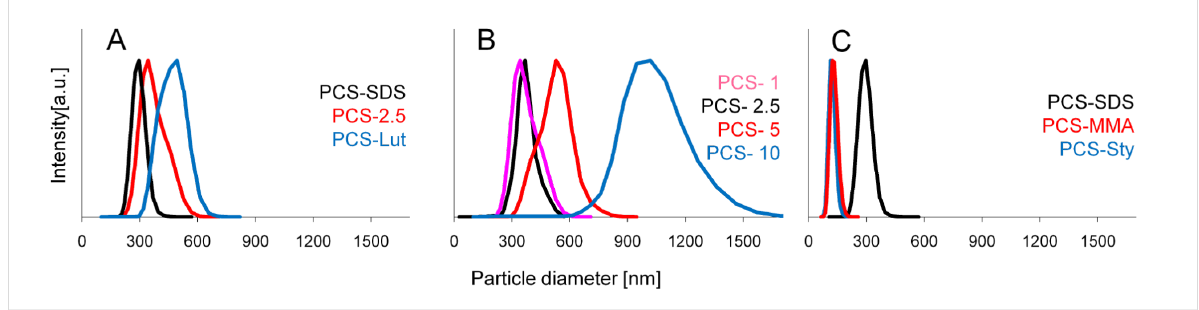
Figure 2: Photon cross-correlation spectroscopy (PCCS) measurement of PCS/water miniemulsions with A) different surfactants, B) different concen- tration of CTAB surfactant and C) different comonomers.